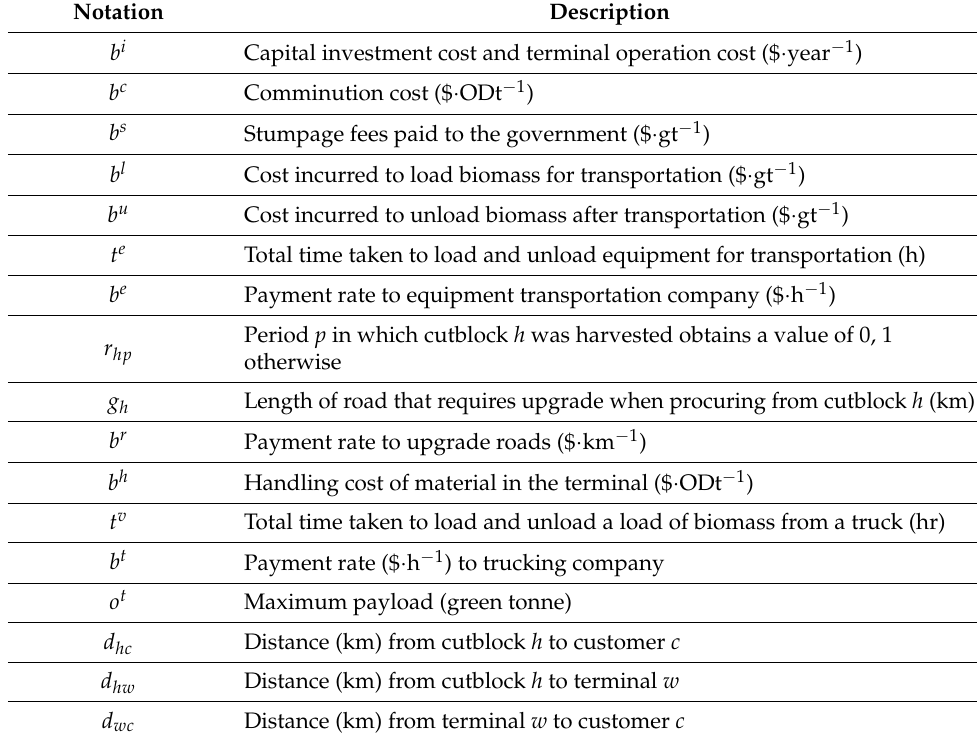
Table 2. Input parameters of the optimization